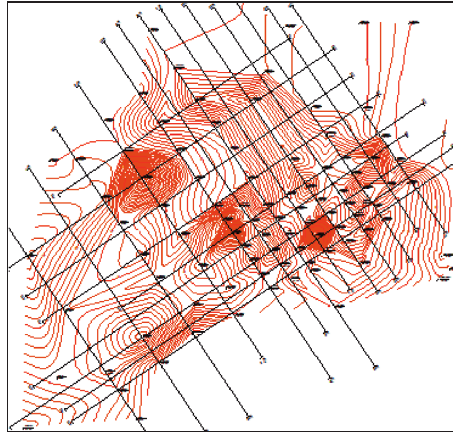
Figure 3: Contour line of ore body floor strata boundary.